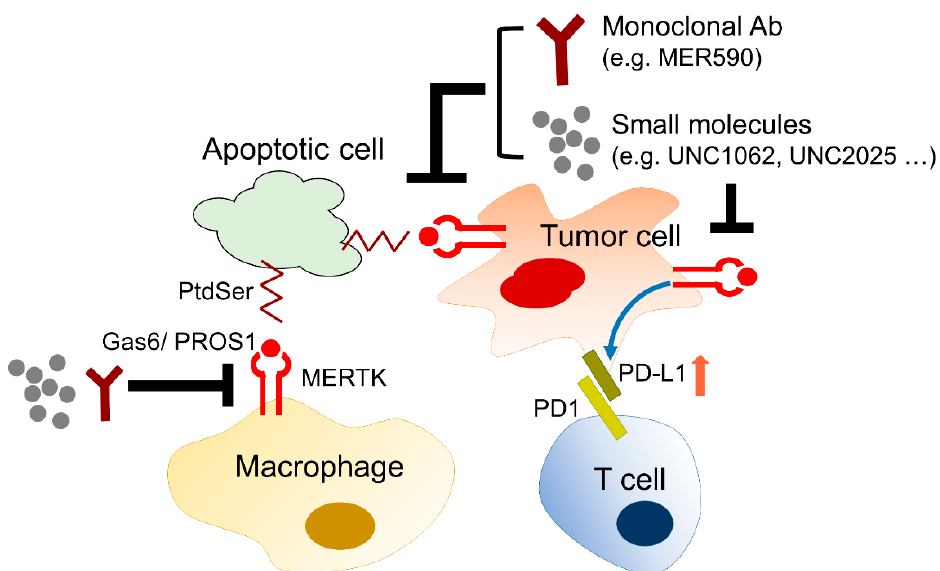
Figure 6. The role of MERTK in microenvironment remodeling. MERTK expressed in cancer cells promotes cell proliferation and survival. In the tumor microenvironment, MERTK-mediated signaling pathways enhance PD-L1 expression in cancer cells leading to the immunosuppression of CD8+ T cells. In addition, apoptotic cancer cells can be eliminated by macrophages through efferocytosis via a PtdSer-Gas6-MERTK, so called “eat me”, signal. Inhibition of MERTK activity by small molecules or monoclonal antibodies may enhance the therapeutic efficacy of anti-cancer agents.